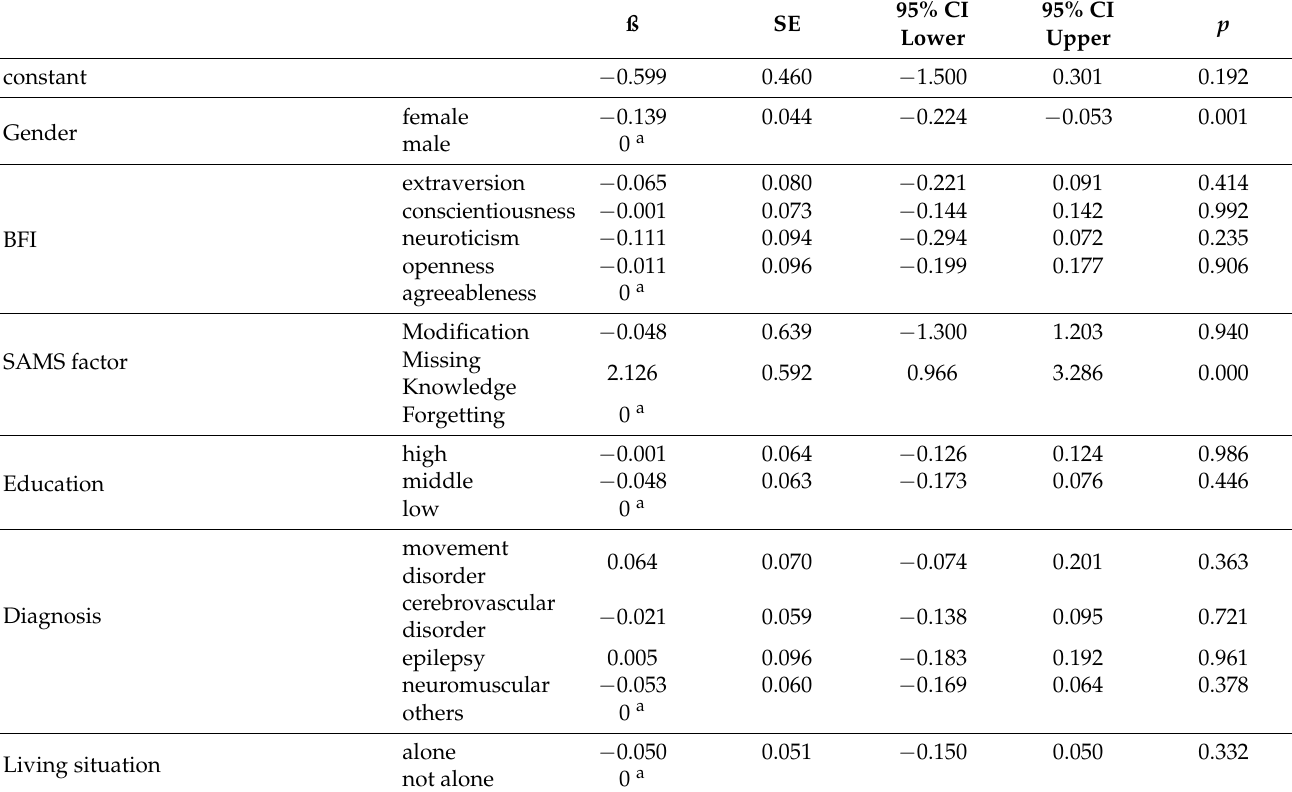
Table 3. Parameter estimators derived from generalized estimating equation